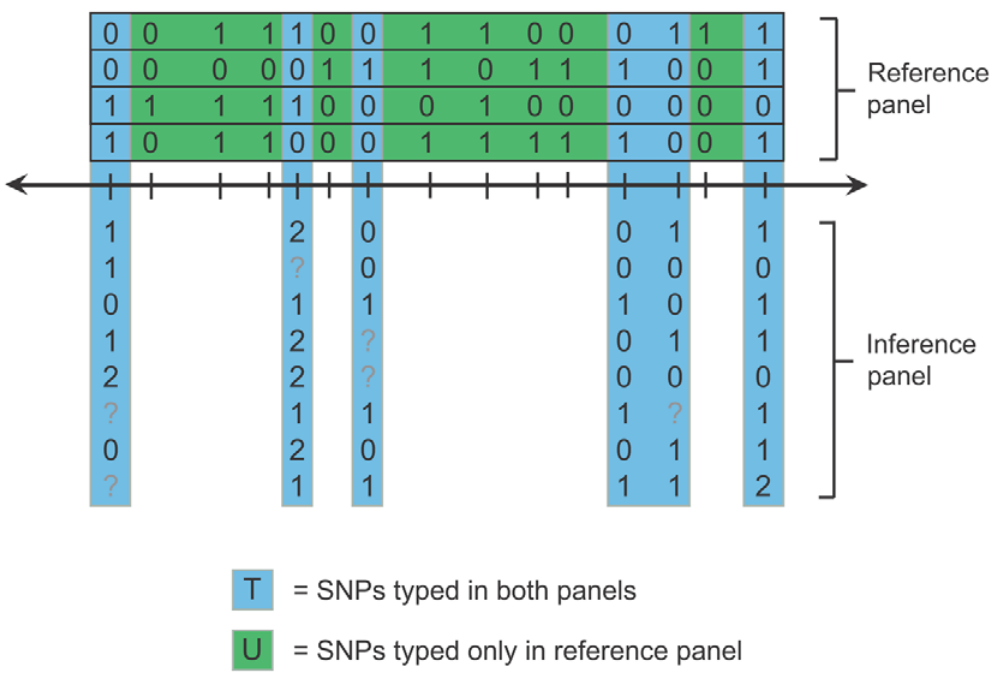
Figure 1. Schematic drawing of imputation Scenario A. In this drawing, haplotypes are represented as horizontal boxes containing 0’s and 1’s (for alternate SNP alleles), and unphased genotypes are represented as rows of 0’s, 1’s, 2’s, and ?’s (where ‘1’ is the heterozygous state and ‘?’ denotes a missing genotype). The SNPs (columns) in the dataset can be partitioned into two disjoint sets: a set T (blue) that is genotyped in all individuals and a set U (green) that is genotyped only in the haploid reference panel. The goal of imputation in this scenario is to estimate the genotypes of SNPs in set U in the study sample.